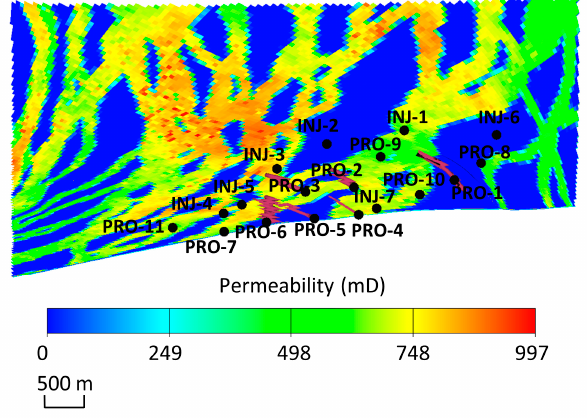
Figure 7. Permeability distribution of Olympus model.